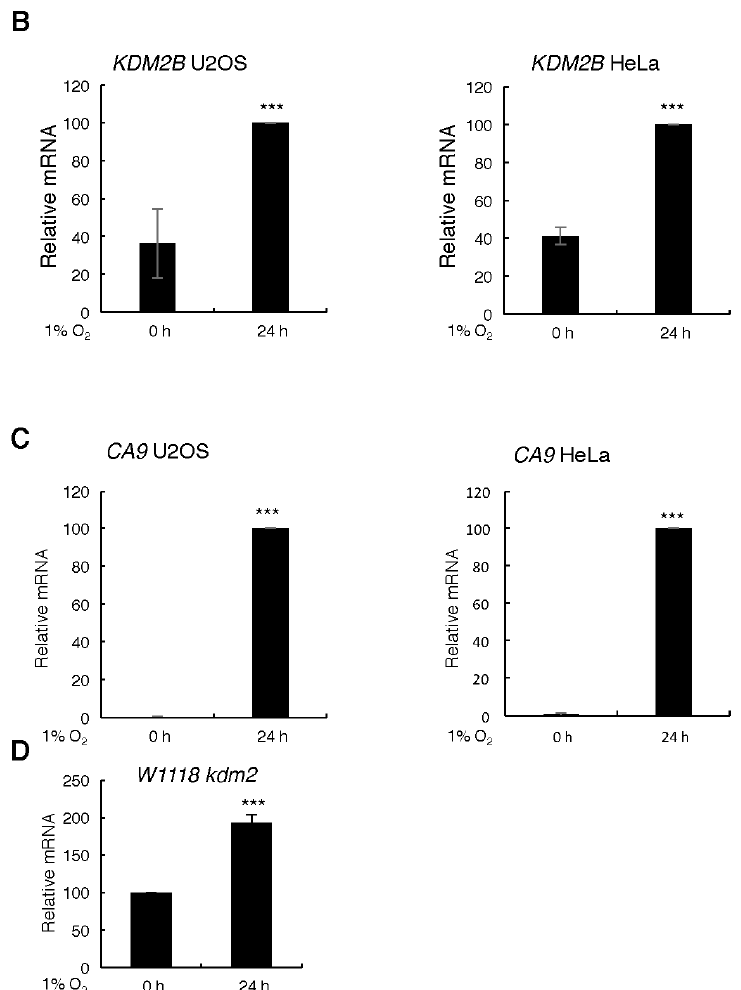
Figure 1. KDM2 mRNA is induced in hypoxia in human and in Drosophila melanogaster . U2OS and HeLa cells were exposed to 1% O 2 for 24 h prior to RNA extraction. Following cDNA synthesis, qPCR analysis was performed for the levels of ( A ) KDM2A, ( B ) KDM2B, and ( C ) CA9 mRNA. Graphs depict mean and standard deviation from a minimum of three independent experiments performed in